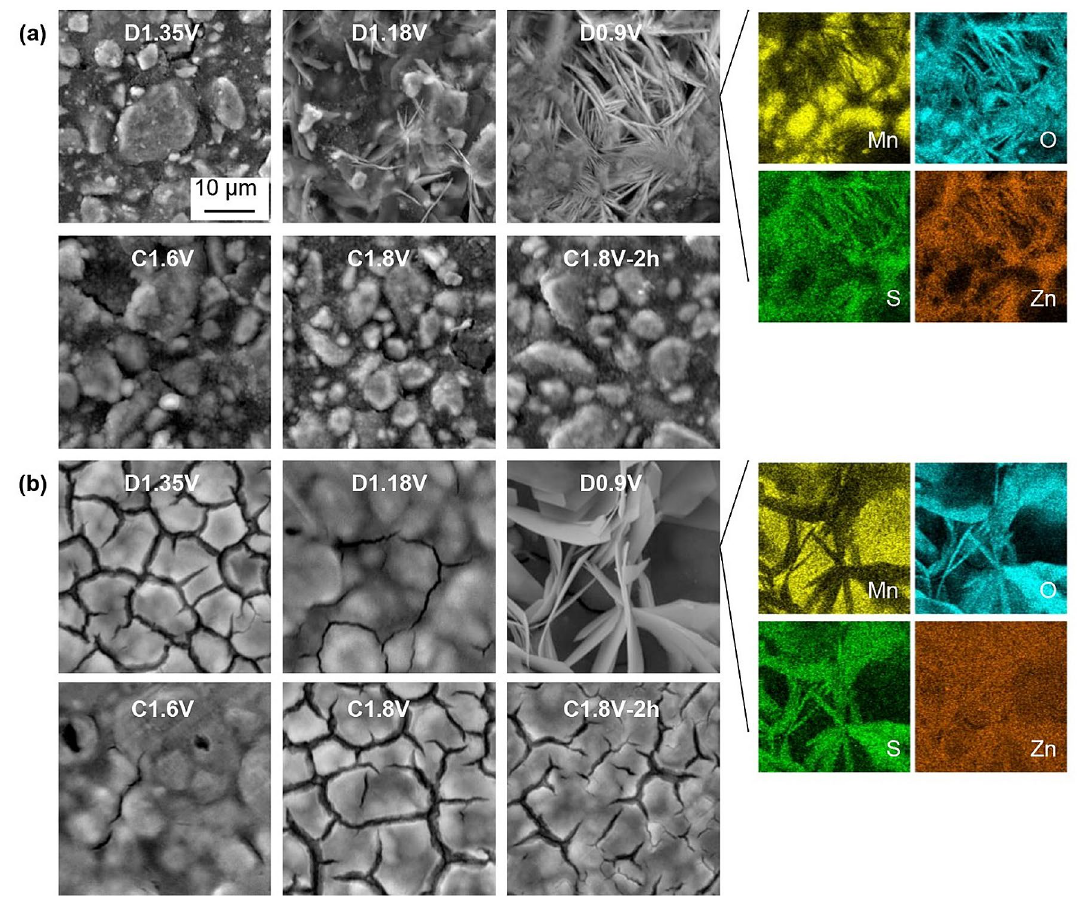
Figure 6. SEM SE images of EMD electrodes at different potentials during cycling tests. ( a ) Conditioning cycle at 0.5 mA cm –2 and ( b ) the 5th cycle at 1 mA cm –2 . EDX maps for the D0.9 V images. Discharge and charge processes are denoted as D and C,